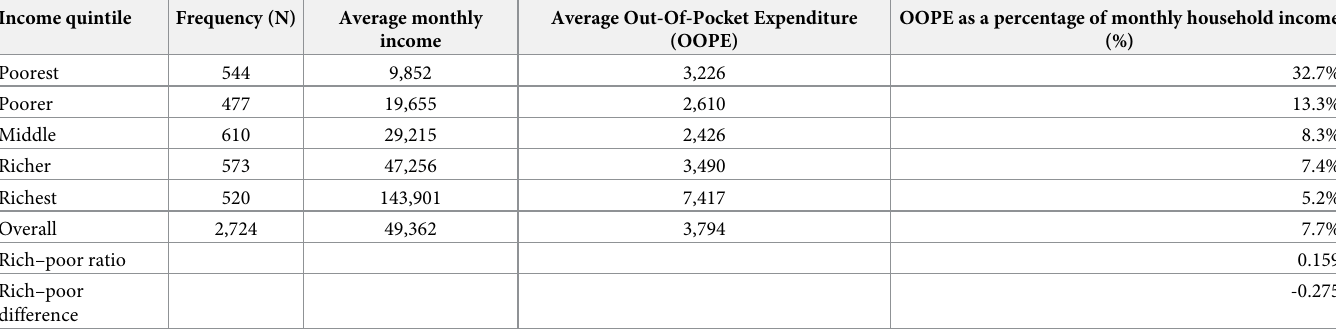
Table 4. Cost burden across socioeconomic